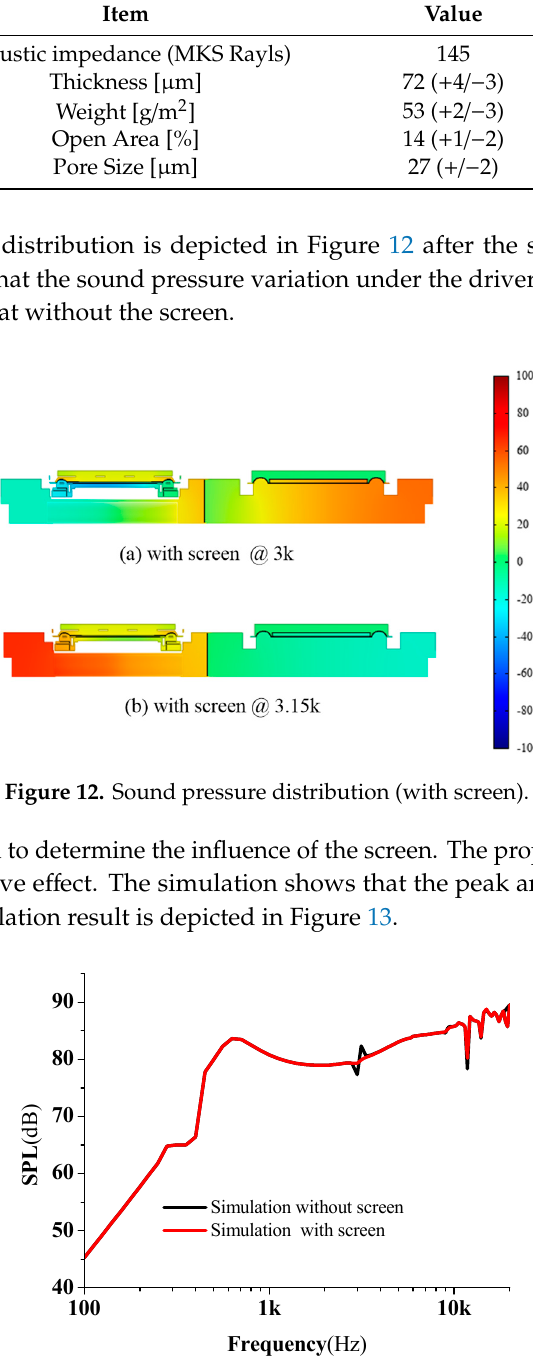
Figure 13. SPL result comparison (with/without screen).